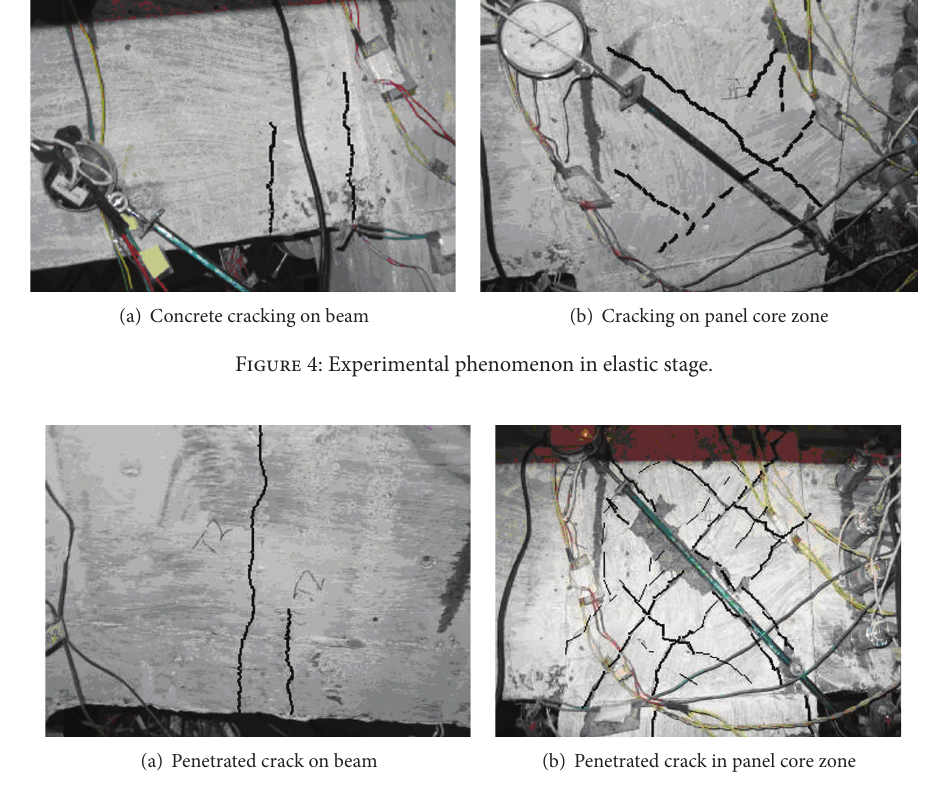
Figure 5: Experimental phenomenon in cracking